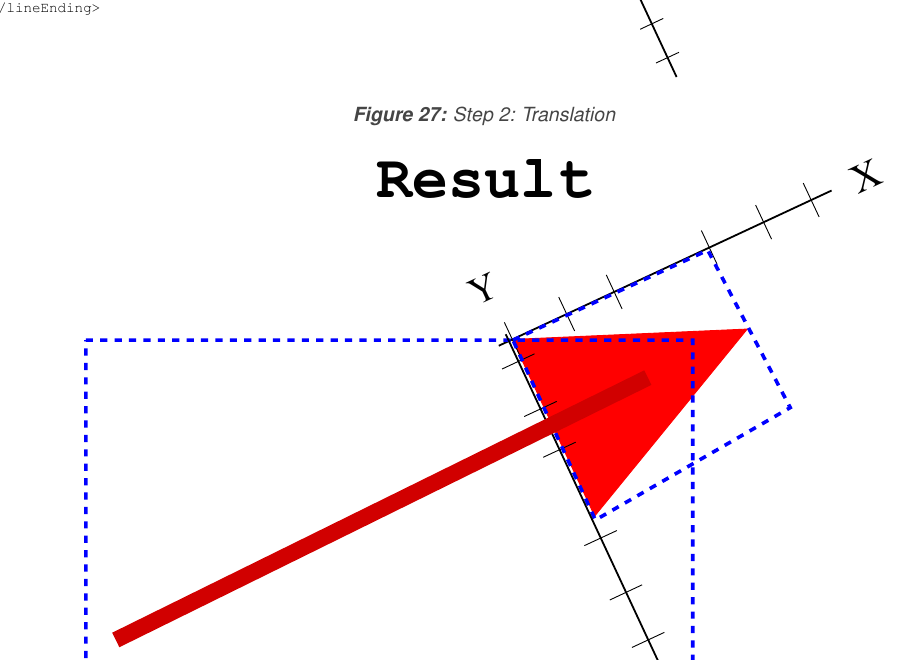
Figure 27: Step 2: Translation